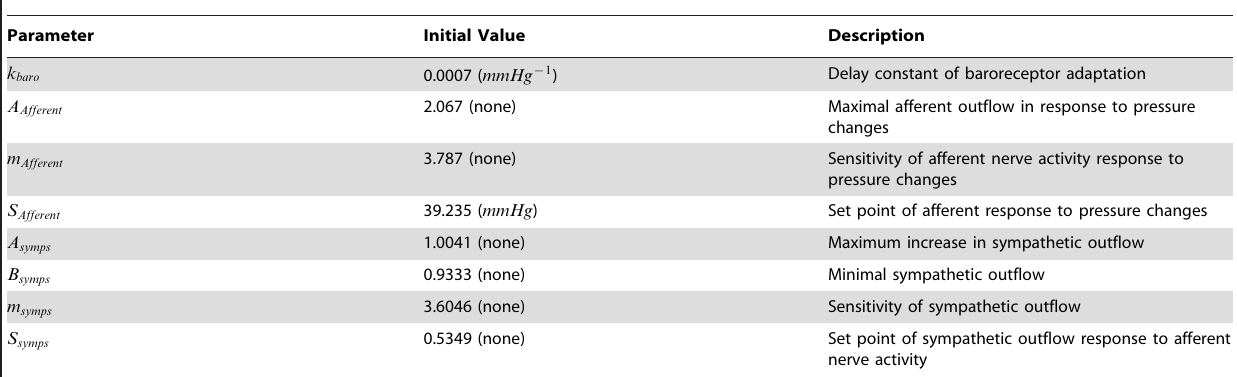
Table 2. Parameters of the baroreceptor reflex.